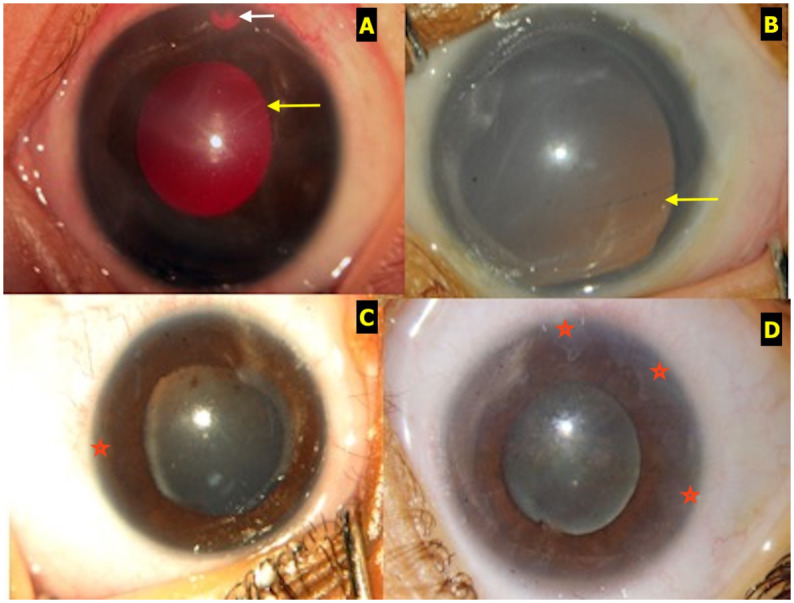
A: Anterior segment photograph showing an eye with ROP and secondary glaucoma that underwent combined trabeculotomy with trabeculectomy. Note the patent surgical PI (white arrow), clear cornea and Habb’s striae (yellow arrow). B: Anterior segment photograph of an eye with ROP post vitreoretinal surgery, aphakia, corneal haze, dilated pupil with ectropion uveae and Habb’s striae (yellow arrow). C: Anterior segment photograph of an eye with ROP post-lens sparing vitreoretinal surgery with dilated fixed pupil, posterior synechiae and few peripheral anterior synechiae (red star). D: Anterior segment photograph of an eye with ROP and angle closure glaucoma with extensive peripheral anterior synechiae (red stars).